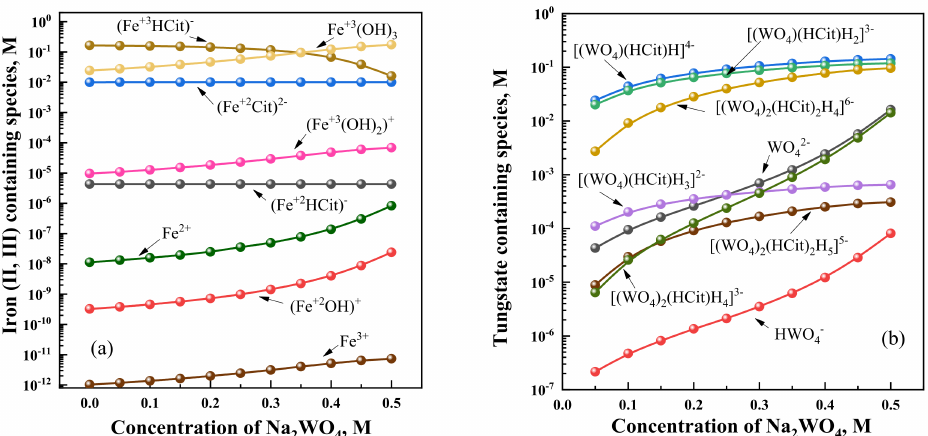
Figure 1. The calculated reversible distribution of main species containing iron (II, III) ( a ) and tungstate ( b ). The oxidation state of Fe is marked in the corresponding formula. Calculations were made for the following salt concentrations: iron (II) sulfate (0.2 M), citric acid + sodium citrate (0.5 M), and sodium tungstate (0.0 to 0.5 M) at pH 6.9. Table 2. Calculated Nernst potentials as a function of sodium tungstate concentration. Concentrations of Fe 2+ , Fe 3+ and WO 42 − ions were taken from Figure 1. The standard reduction potentials (vs Ag/AgCl) = − 0.64 V ; E 0 = − 1.26 V, E 0 = 0.771 V. were used for calculations: E 0 Fe 2 + /Fe WO 2 − 4 /W Fe 3 + /Fe 2 + Nernst Potentials of Systems vs. Ag/AgCl Electrode Concentration of Na 2 WO 4 , M E , V E , V E , V Fe 2 + /Fe Fe 3 + /Fe 2 + WO 2 − 4 /W −